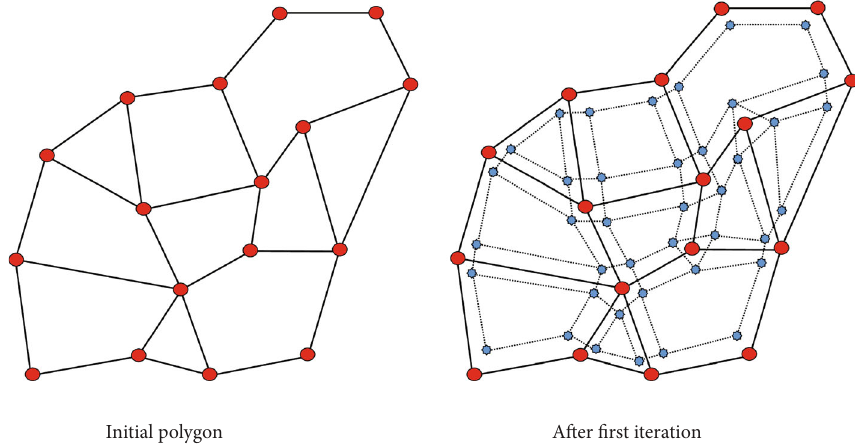
Figure 1: Scheme of computation of new face points by using Doo-Sabin subdivision